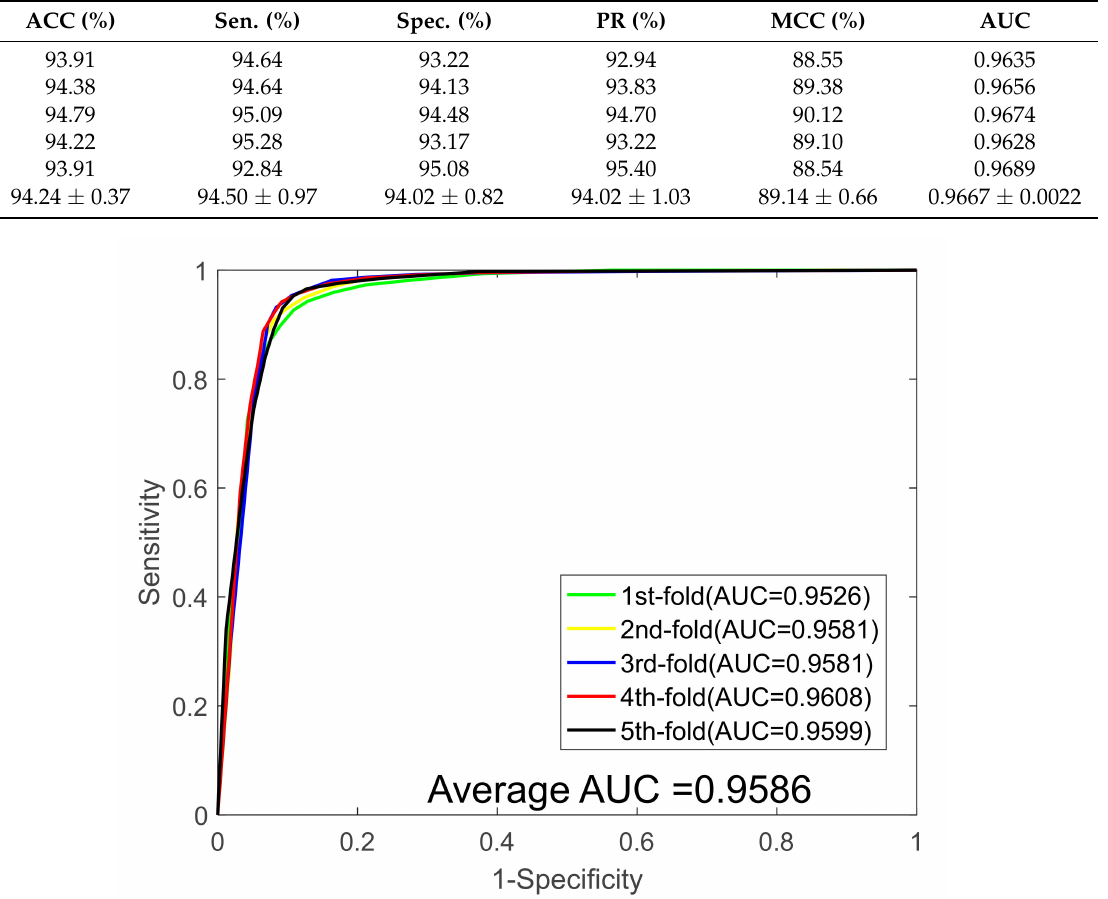
Figure 1. ROC curves generated by the proposed model on the Yeast